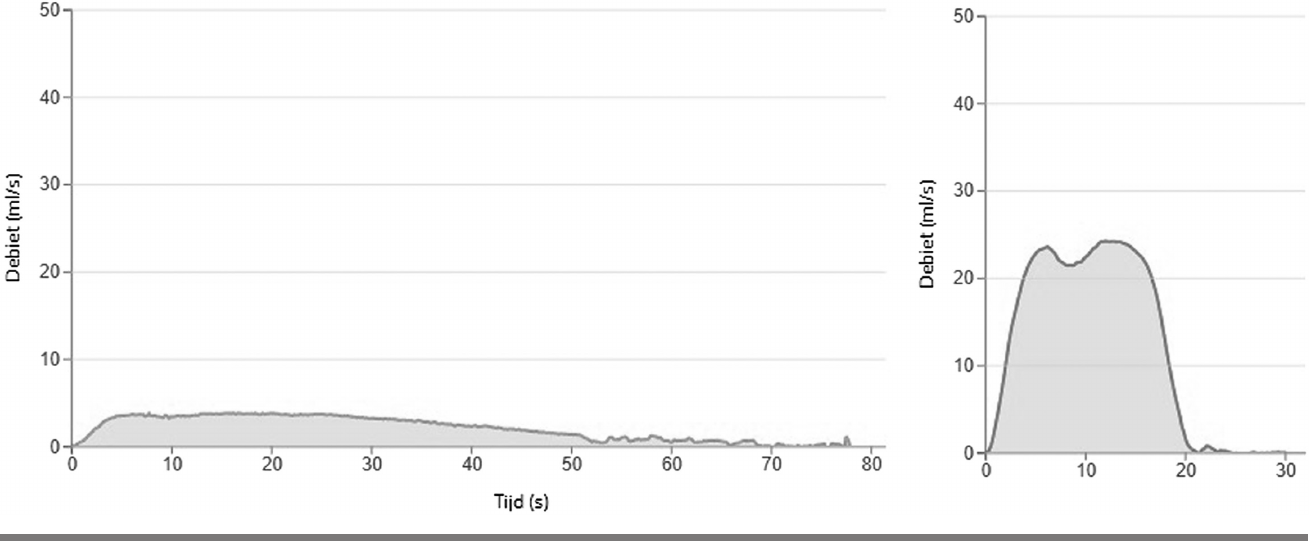
Figure 7. The pre- and postoperative